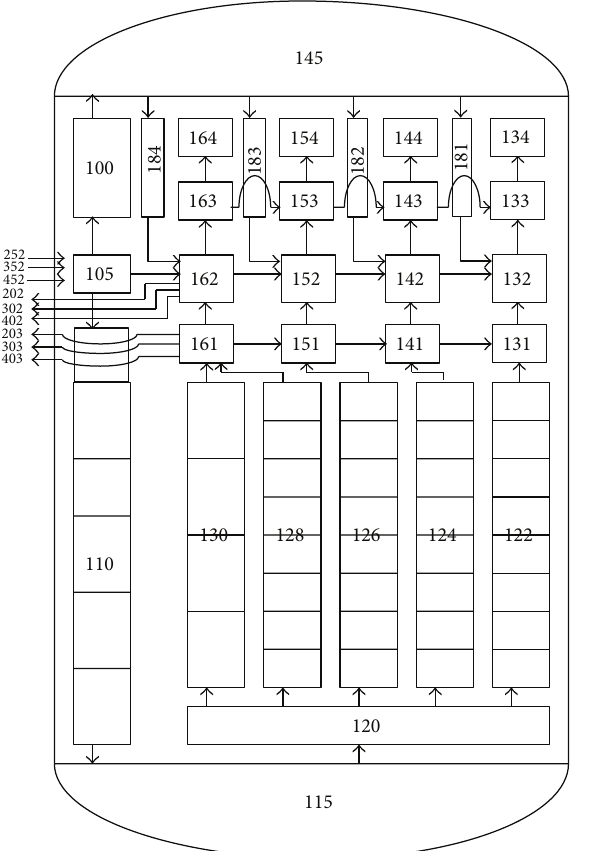
Figure 10: Nodalization of in-vessel natural circulation model.